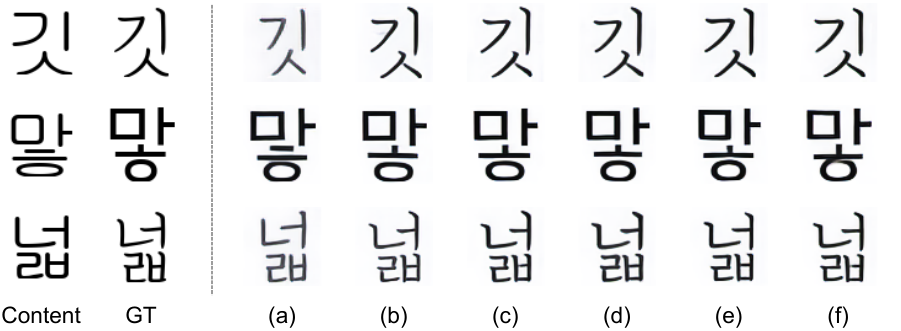
Figure 4. Examples of the generated images for unseen font: Content: content image, GT: image of ground truth font, ( a – f ): generated images with ( a ) single input, ( b ) 4 stack, ( c ) 8 stack, ( d ) 16 stack, ( e ) 24 stack, and ( f ) 32 stack for both content and style inputs.